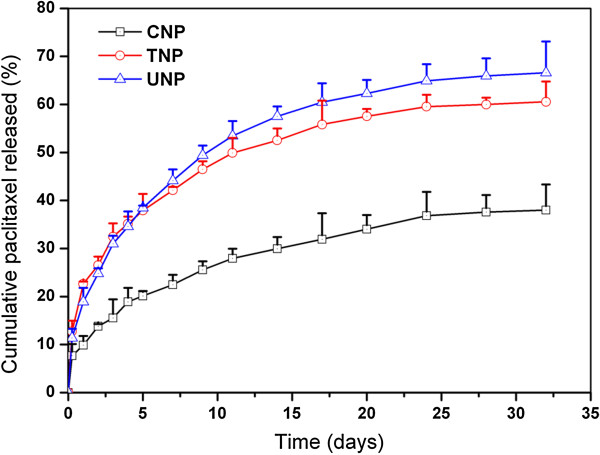
The in vitro release profiles of paclitaxel-loaded CNP, UNP, TNP.